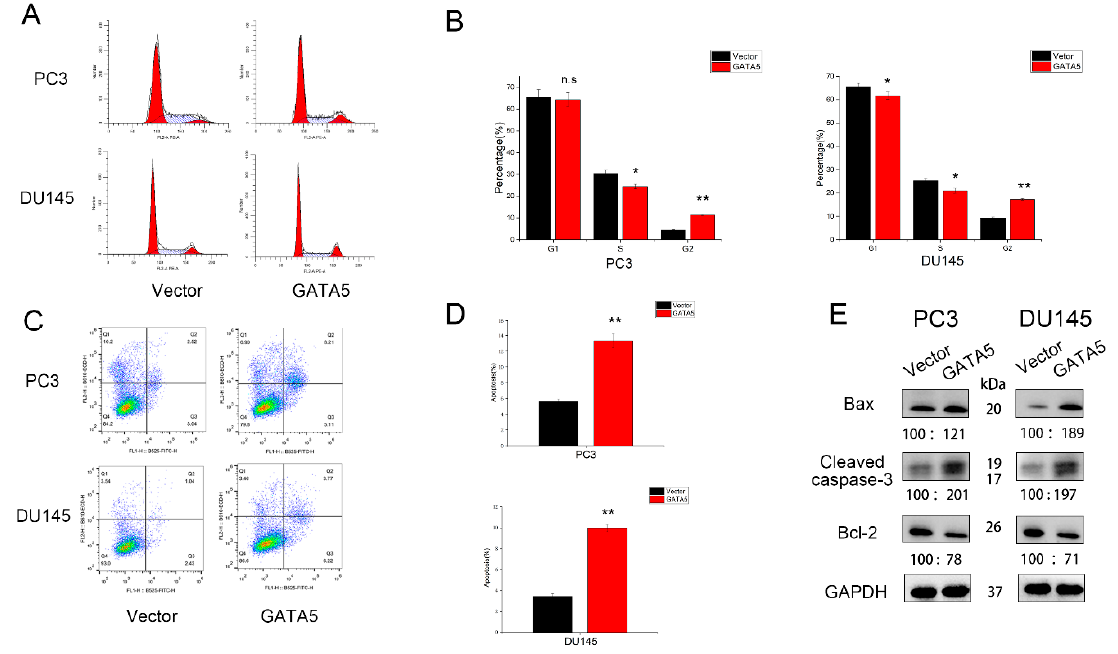
Figure 3. GATA5 overexpression promotes the cell cycle arrest and induces the apoptosis of PCa cells. ( A , B ) The results showed that GATA5 regulated the cell cycle. GATA5 overexpression elevated the G2 fraction of PCa cells. ( C , D ) The apoptotic rate in the pc-GATA5 groups was higher than in the pc-vector group. ( E ) The analysis of Western blotting clarified that GATA5 overexpression increased the apoptosis markers, Bax and Cleaved caspase-3, but decreased Bcl-2. Data are presented as mean ± SD of at least three experiments. * p < 0.05 and ** p < 0.01.